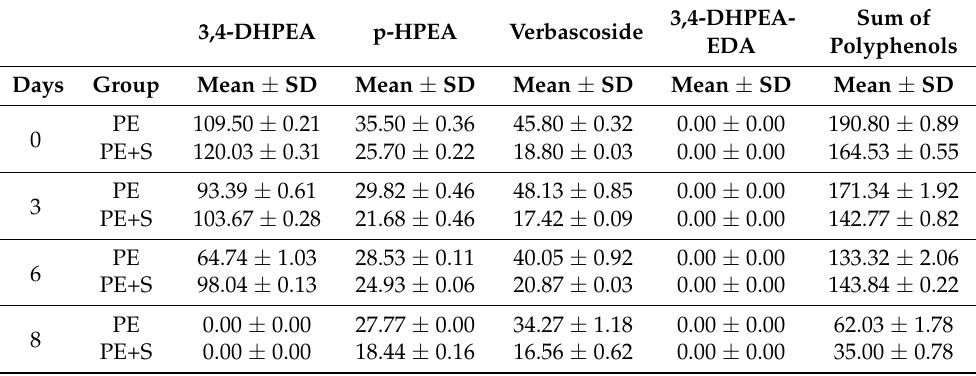
Table 2. Phenolic compounds (mg/kg) evolution during storage in cooked shrimps (after boiling) treated with tap water solution containing 2 g/L of phenols (PE) and 0.25% sodium metabisulfite tap water solution containing 1 g/L of phenols